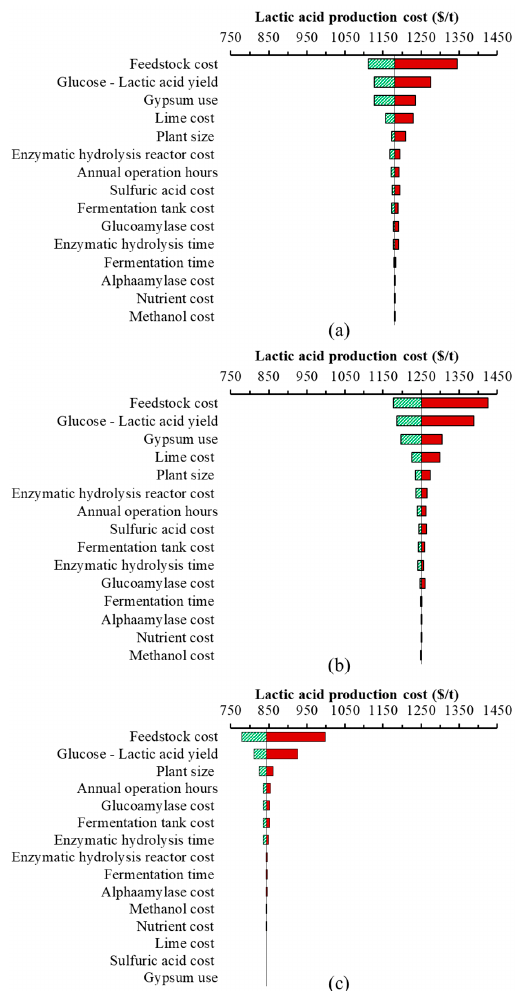
Figure 5. Sensitivity analyses of different parameters on lactic acid production costs for fermentation pathways using ( a ) bacteria, ( b ) fungi and ( c ) yeast. pathways using ( a ) bacteria, ( b ) fungi and ( c ) yeast.